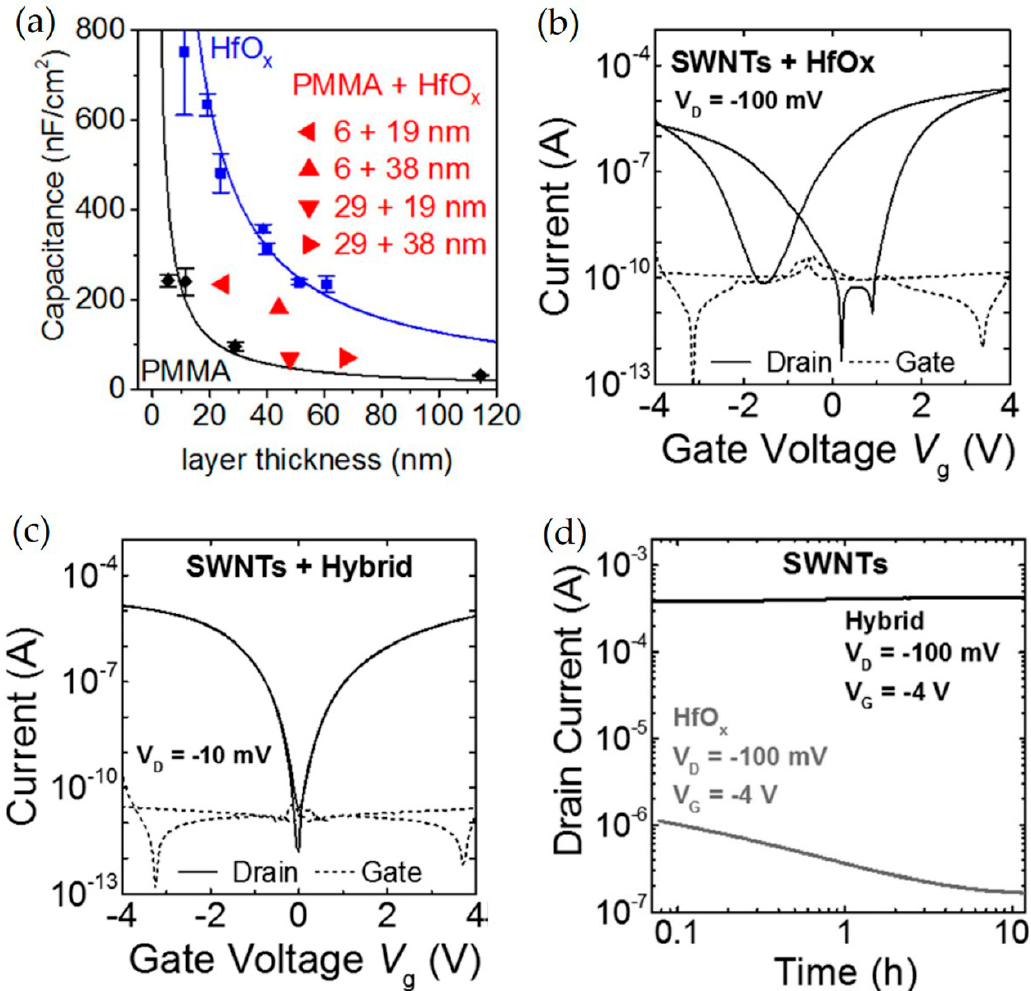
Figure 10. ( a ) Capacitance as a function of total layer thickness for hafnium oxide, PMMA, and hybrid dielectric. Transfer characteristics of network SWNT FETs with ( b ) HfO x and ( c ) hybrid dielectric. Channel width / length ratio and channel lengths were 125 and 40 µ m, respectively. ( d ) Bias stress tests of SWNT-based transistors with different dielectrics. Reproduced with permission from [136], Copyright 2015 American Institute of Physics.